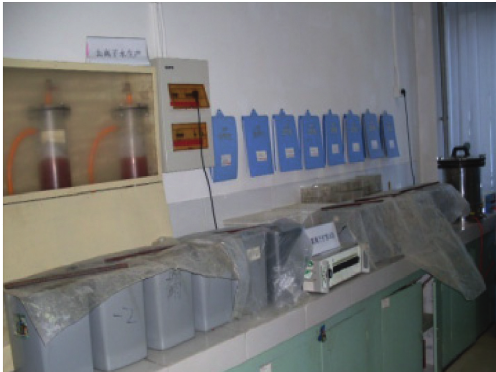
Figure 3: The electric flux test.